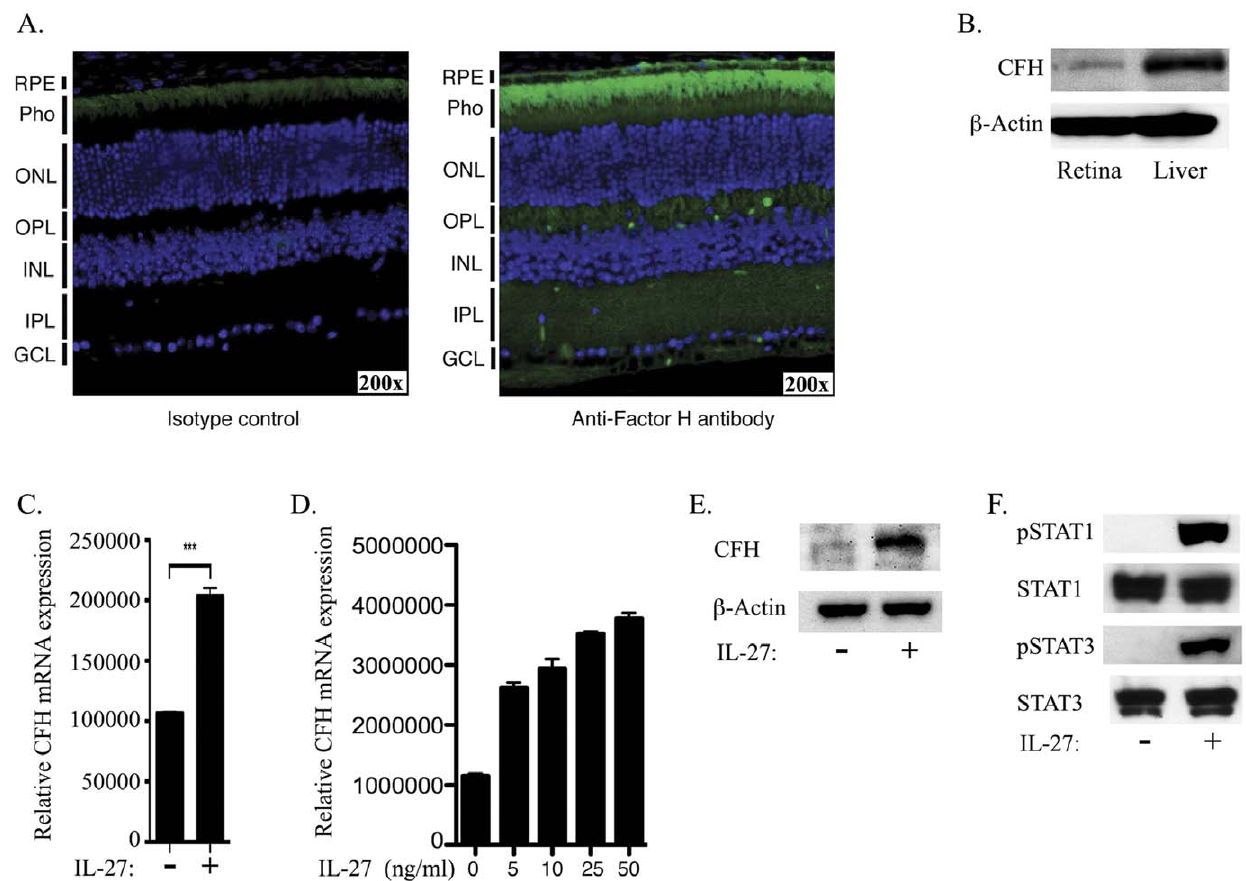
Figure 1. CFH is constitutively expressed in the retina and up-regulated in RPE cells by IL-27 through STAT1-dependent mechanism. (A) Immunohistochemical localization of CFH expression in the mouse retina. Retina pigmented epithelium (RPE); Photoreceptors (pho); outer nuclear layer (ONL); outer plexiform layer (OPL); inner plexiform layer (IPL). (B) Whole cell extracts prepared from the retina or liver of C57BL/6 mice were analyzed for expression of CFH by Western blot assay. (C) ARPE-19 cells were stimulated for 24 hours in medium containing human IL-27 (10 ng/ml). ARPE-19 cells were cultured overnight in complete medium, washed and starved in serum free medium (SFM) for 2 hours and then stimulated in SFM containing human recombinant IL-27 (10 ng/ml) for 24 hours (C, D, E) or 30 minutes (F). (C) RNA was isolated and analyzed by qRT-PCR. (D) The ARPE-19 cells were stimulated with several concentrations of human IL-27 and then subjected to qRT-PCR analysis. (E, F) Whole cell extracts were analyzed by Western blot